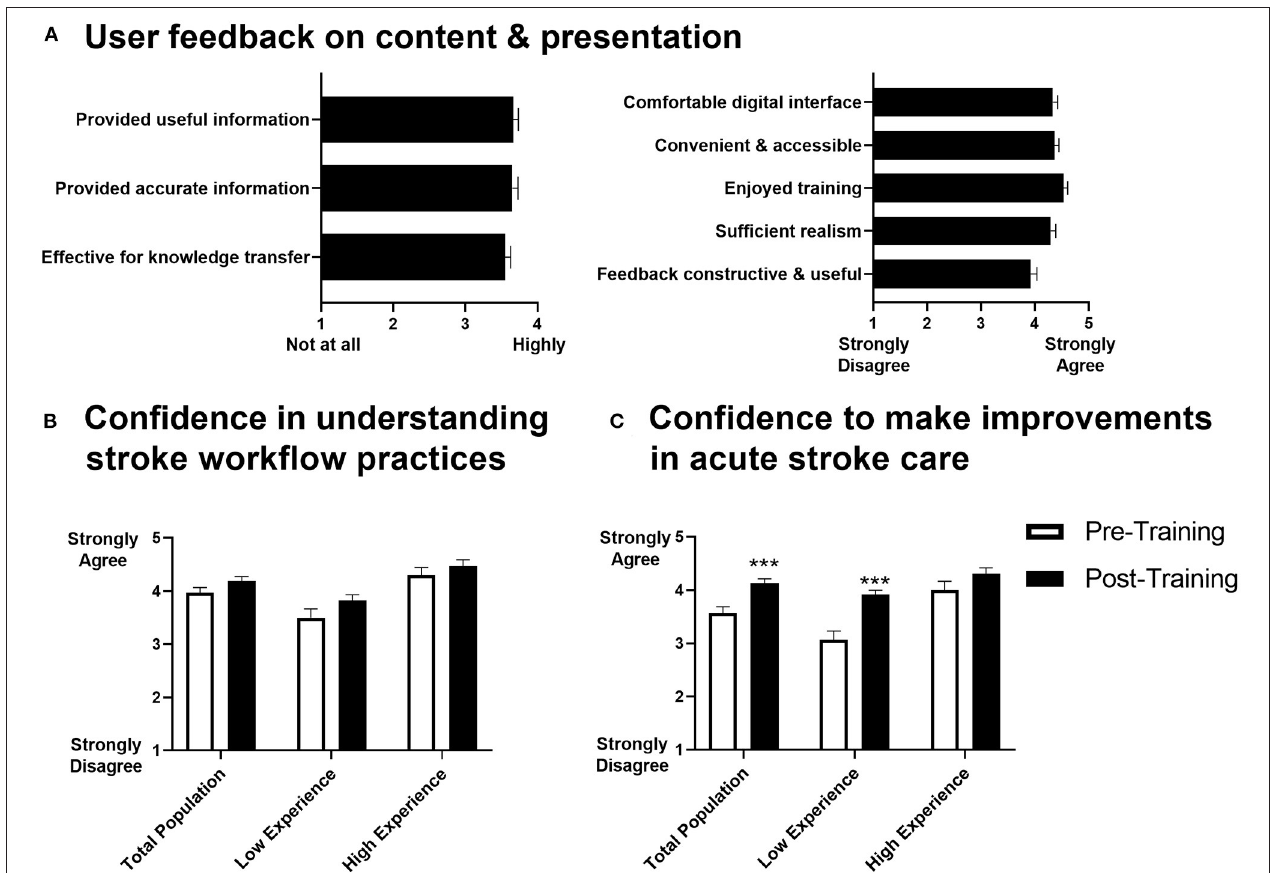
FIGURE 4 | User survey feedback on TACTICS VR. (A) User feedback on content and presented information, (B) user confidence in understanding of stroke workflow practices and (C) user confidence to make improvements in acute stroke care ( n = 53-58; n = 14 “low experience” = ≤ 10 patients cared for/treated; n = 18 “high experience” = > 40 patients cared for/treated; data presented as mean + /– SEM; *** p <